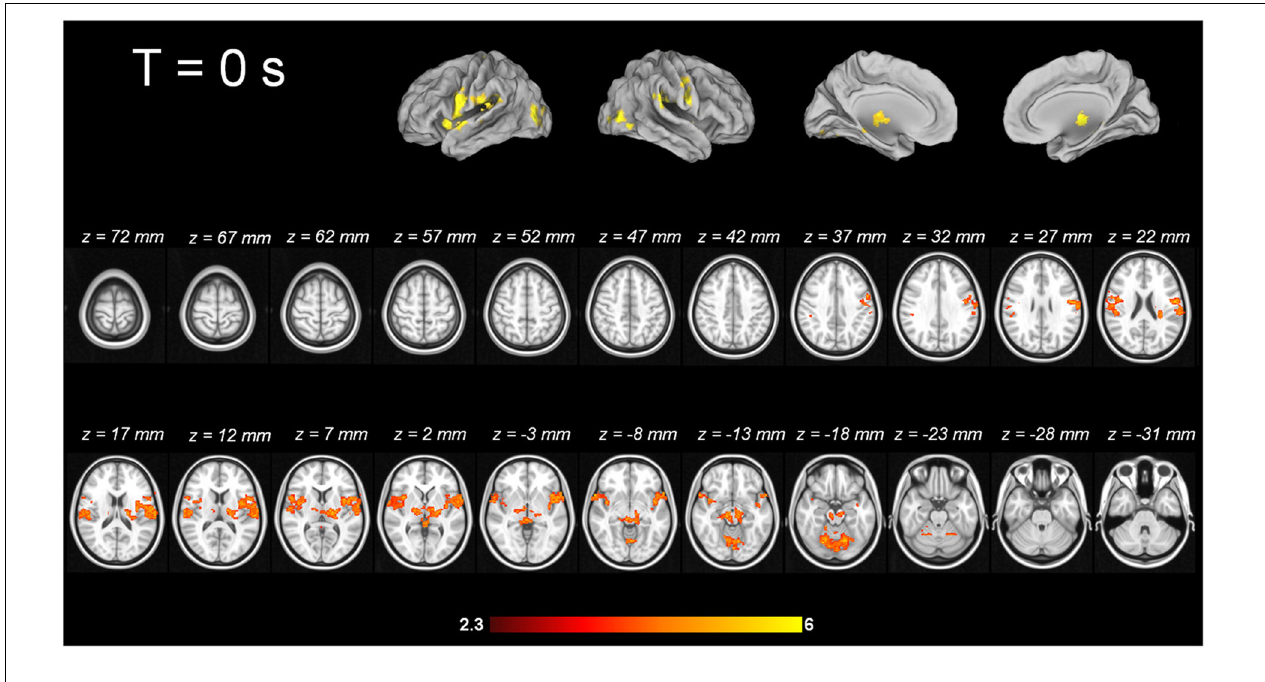
FIGURE 3 | Tic-related